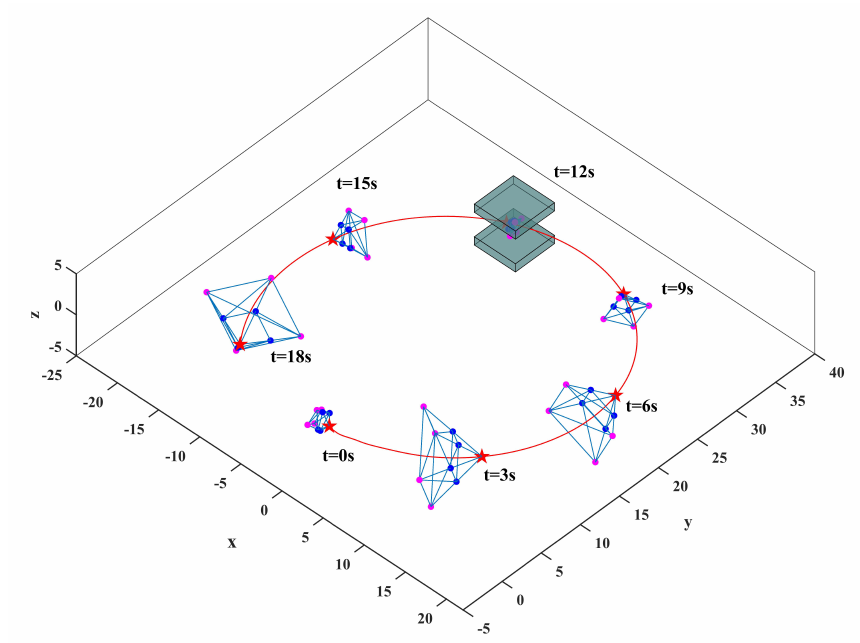
Figure 5. Dynamic formation trajectory diagram.